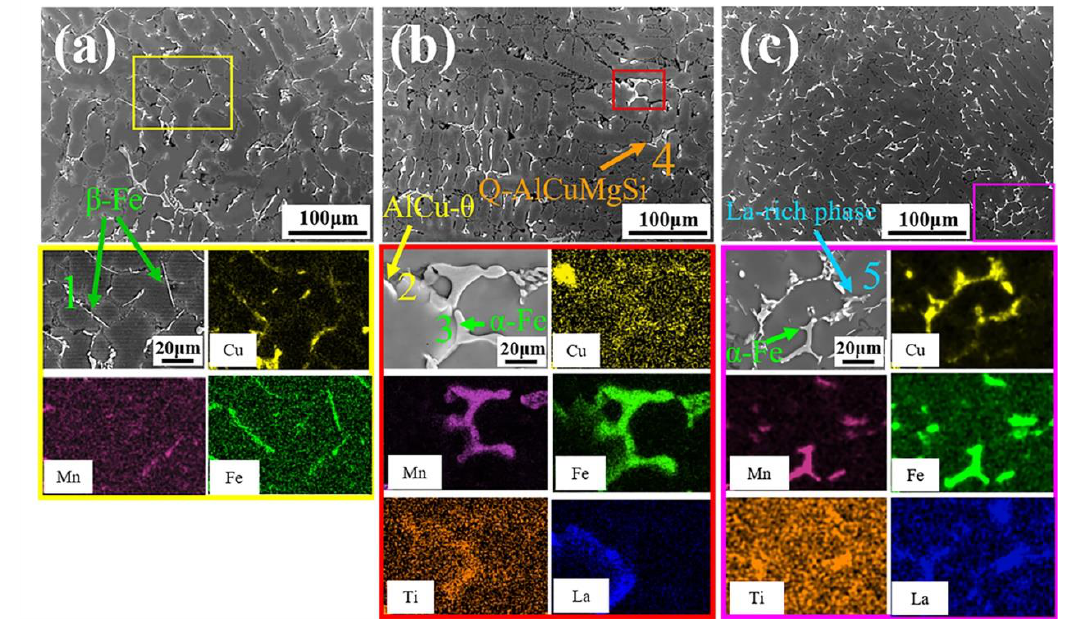
Figure 5. As-cast SEM/EDS micrographs of the ( a )Base; ( b ) AlTiB + 0.05La; ( c ) AlTiB + 0.3La. The different colors of numbers are meant to correspond to different elements in the EDS image. Table 2. Composition of intermetallic phases (at.%)in as-cast alloy.